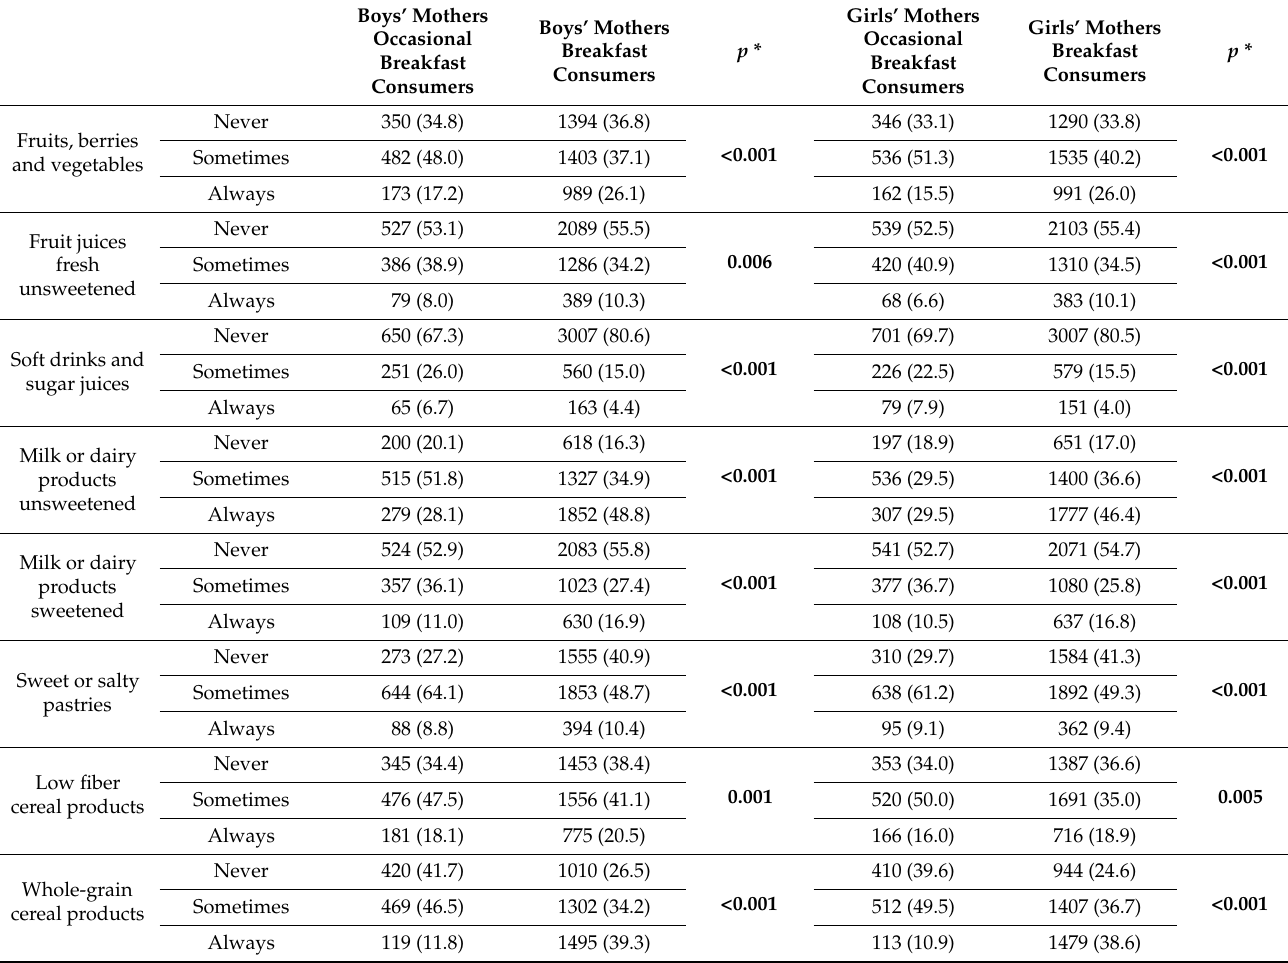
Table 3. Description of food and beverages consumed at breakfast in mothers who occasionally or usually consumed